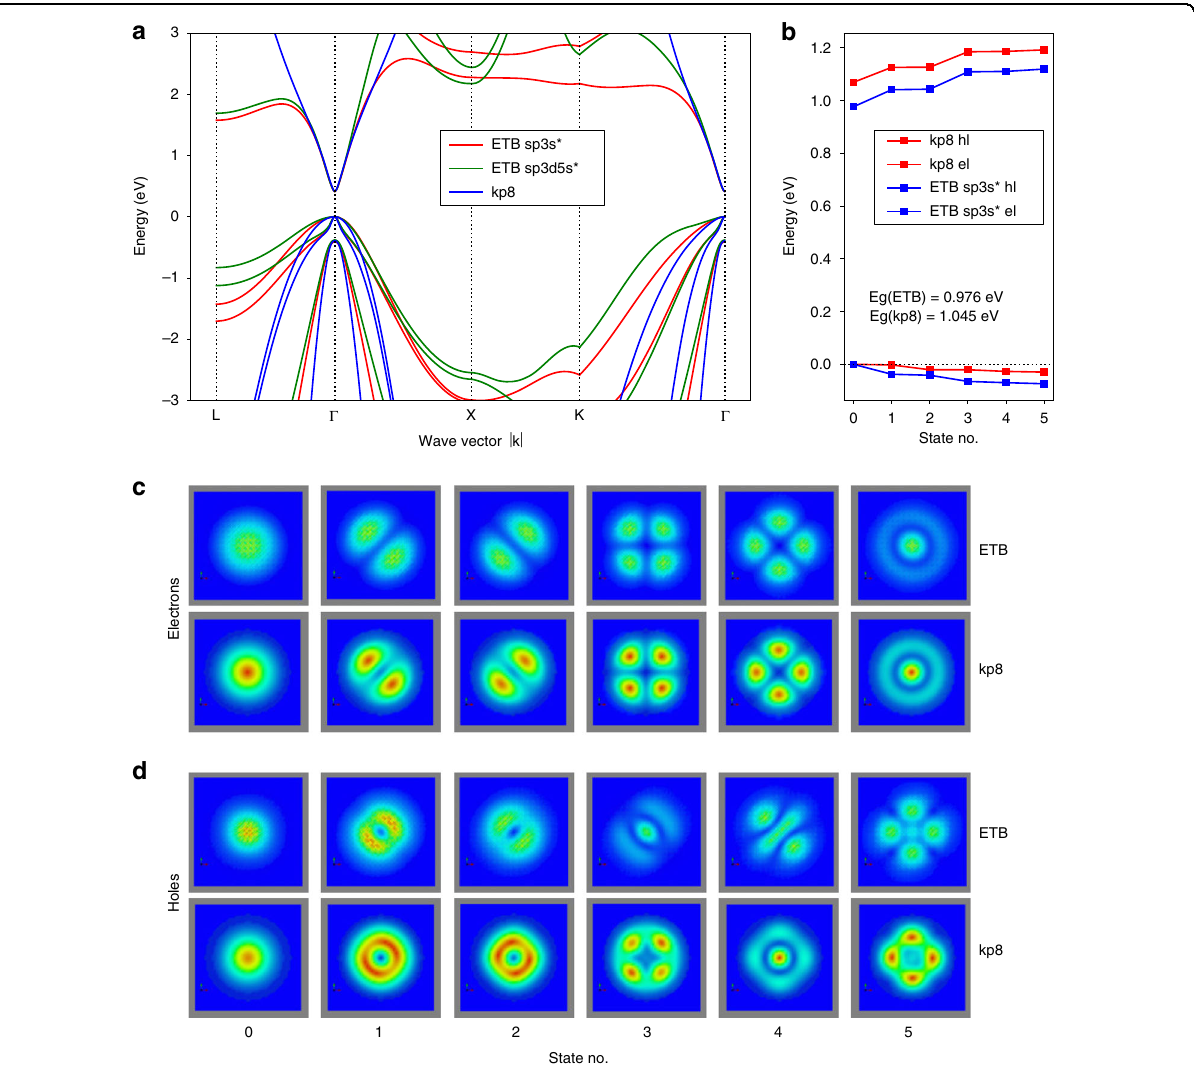
Fig. 3 Comparison of the results obtained by eight-band k·p (kp8) and sp 3 s* empirical tight-binding (ETB) methods for electronic states of truncated pyramid InAs QD in GaAs matrix with height, basis dimension, and InAs wetting layer thickness of 2.2 nm, 20 nm, and 0.5 nm, respectively. In a , we show the band structure of InAs computed using the sp 3 s*, sp 3 d 5 s* ETB, and 8-band k·p method. In b , we give the eigenenergies of the six states lowest in energy computed by k·p and ETB for electrons (el) and holes (hl), respectively. The lateral cuts, taken 1 nm above the base of QD, of the corresponding probability densities are shown in c for electrons and d for holes. Note that electrons and holes are fully con fi ned inside QD for both k·p and ETB. Notice the apparent similarity between ETB and k·p results, particularly for the lowest